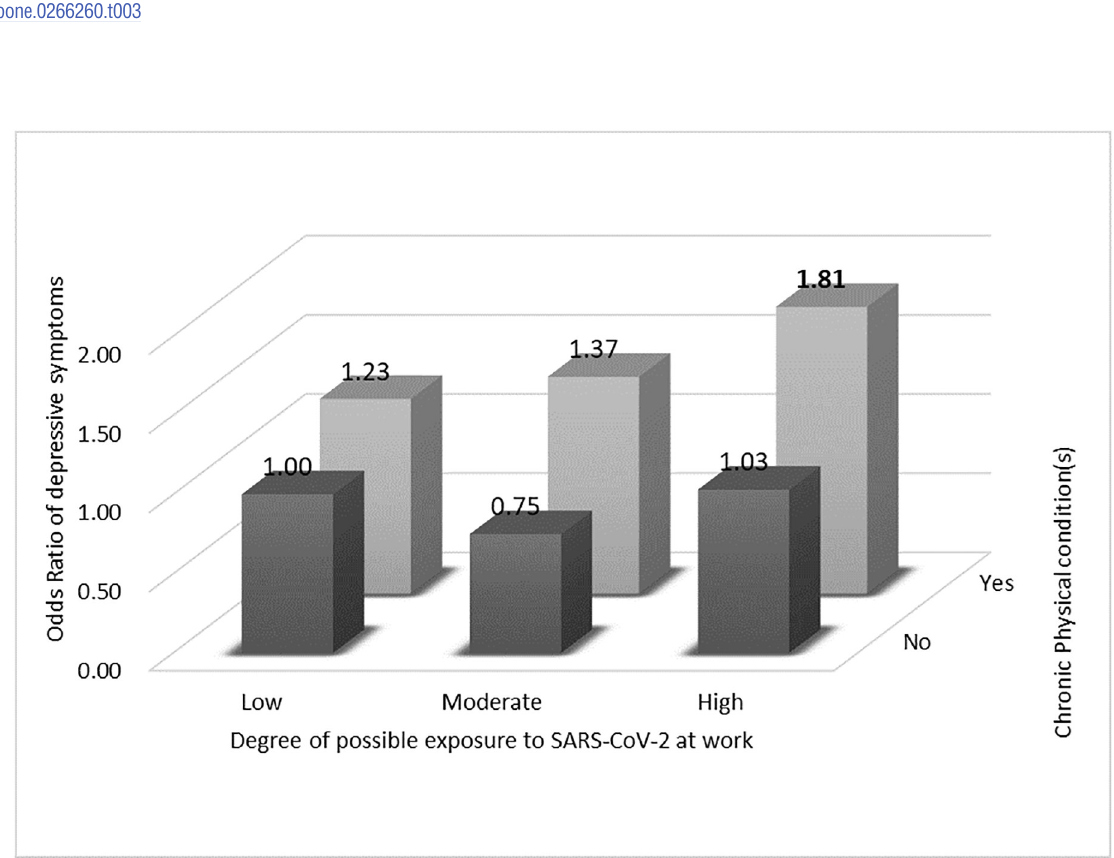
Fig 1. The combined association of chronic physical condition(s) and degree of possible exposure to SARS-CoV-2 at work with depressive